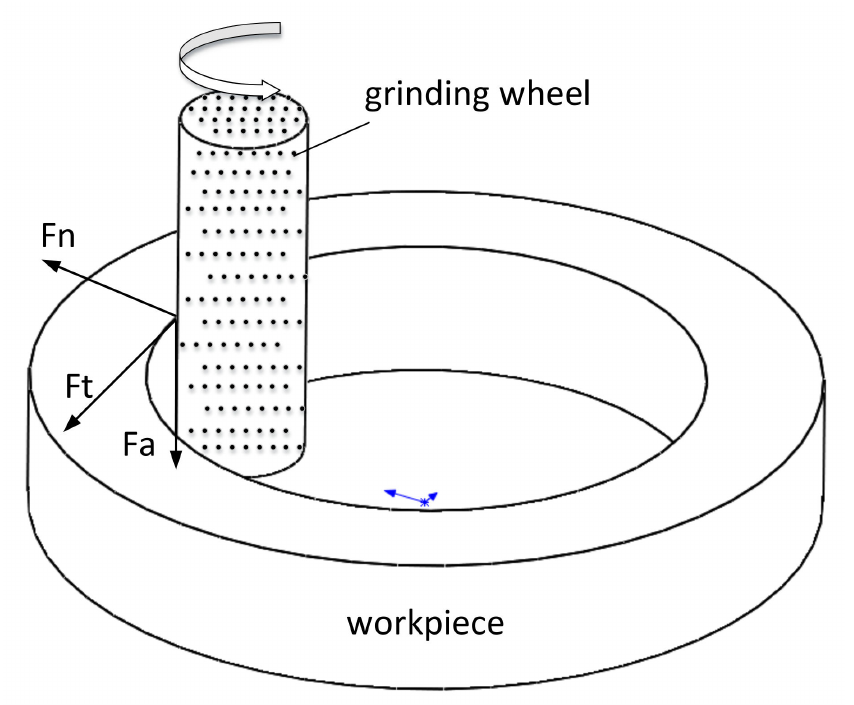
Figure 1. Force analysis diagram of internal